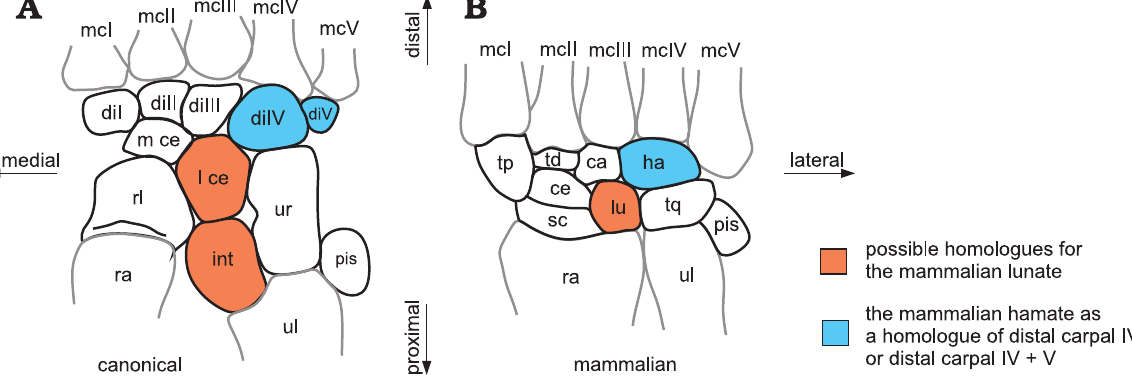
Fig. 1. Schematic diagrams of a non-therapsid synapsid (“pelycosaur”) carpus ( A ) and a mammaliaform carpus ( B ), labelled using the canonical and mammalian nomenclatures. Abbreviations: ca, capitate; ce, centrale; di, distal carpal; ha, hamate; int, intermedium; l ce, lateral centrale; lu, lunate; mc, metacarpal; m ce, medial centrale; pis, pisiform; ra, radius; rl, radiale; sc, scaphoid; td, trapezoid; tp, trapezium; tq, triquetrum; ul, ulna; ur, ulnare.